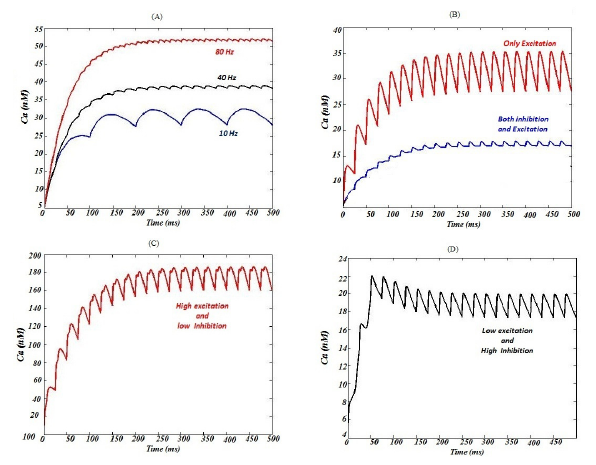
Figure 6. Plasticity of Ca 2+ signals. Panel (A): Modulation of calcium signals in response to synaptic activity in spines. All of the four channels are contributing with equal activity level, blue line for the α -range activity, black line for medium γ -range activity and red line for high γ − activity. Panel (B): Simulation for the cases of no excitation , no inhibition and also the coexistence state (when both are present). Ca 2+ signals strongly inhibit in the presence of active GABA R’s. Panel (C): Excitation is increased ten times by the the inhibition and an excessive increase in calcium signals can be seen. This can be referred as the case of seizure. Panel (D): Now the inhibition is increased by ten